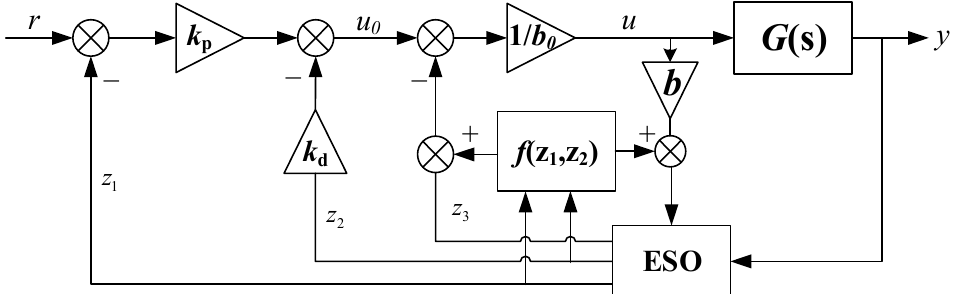
Figure 2. The modified active disturbance rejection control (MADRC) block diagram for the second-order system.